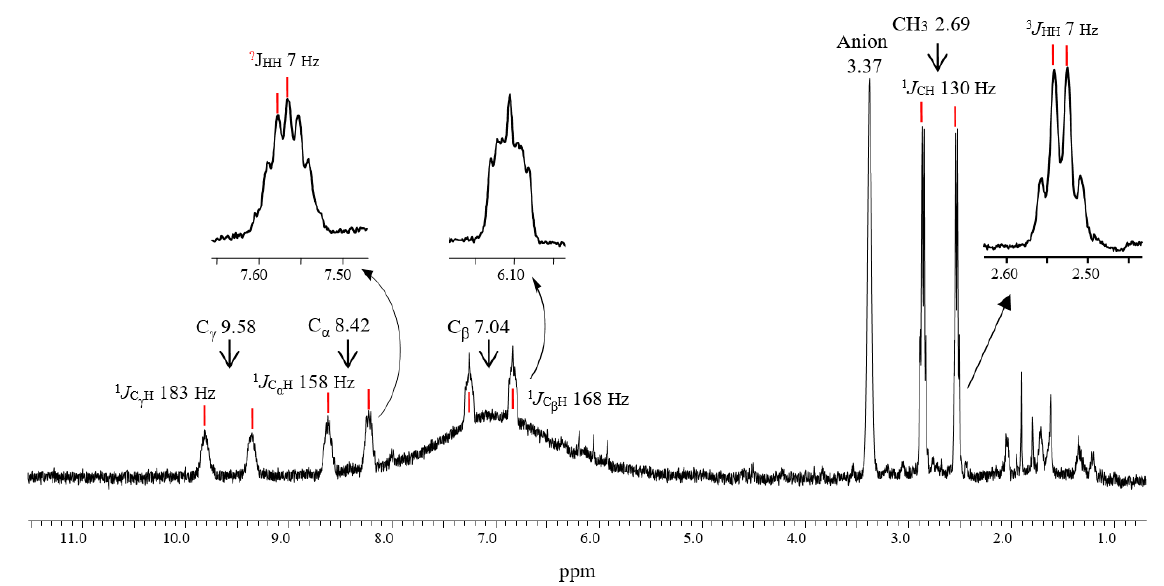
Figure 9. The 1 H NMR spectrum of the C 4 H 6 Cl + {Cl 11 − } solution in SO 2 ClF. The broad signal at ~7 ppm belongs to protonated water.